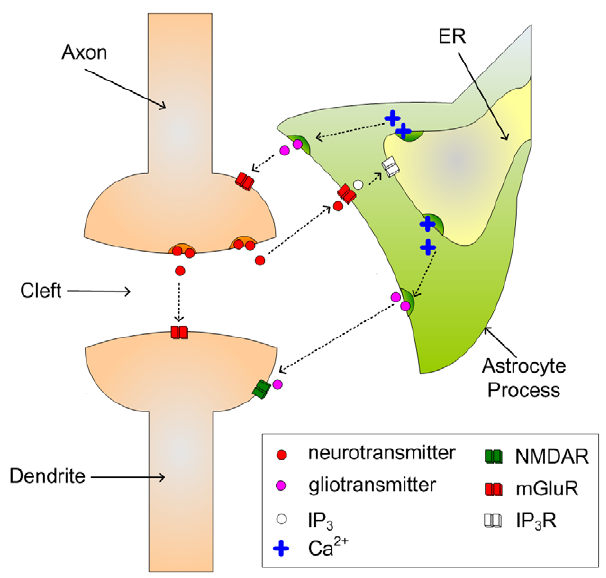
Figure 1. A Tripartite Synapse. The axon and dendrite, which are involved with the release and postsynaptic action of neurotransmitter respectively, are also connected to an astrocyte process which is sensitive to neurotransmitter. In response to neuronal neurotransmitter release the astrocyte can release further neurotransmitter (called gliotransmitter) which regulates the Excitatory Post-Synaptic Current (EPSC) generated by the postsynaptic neuron.